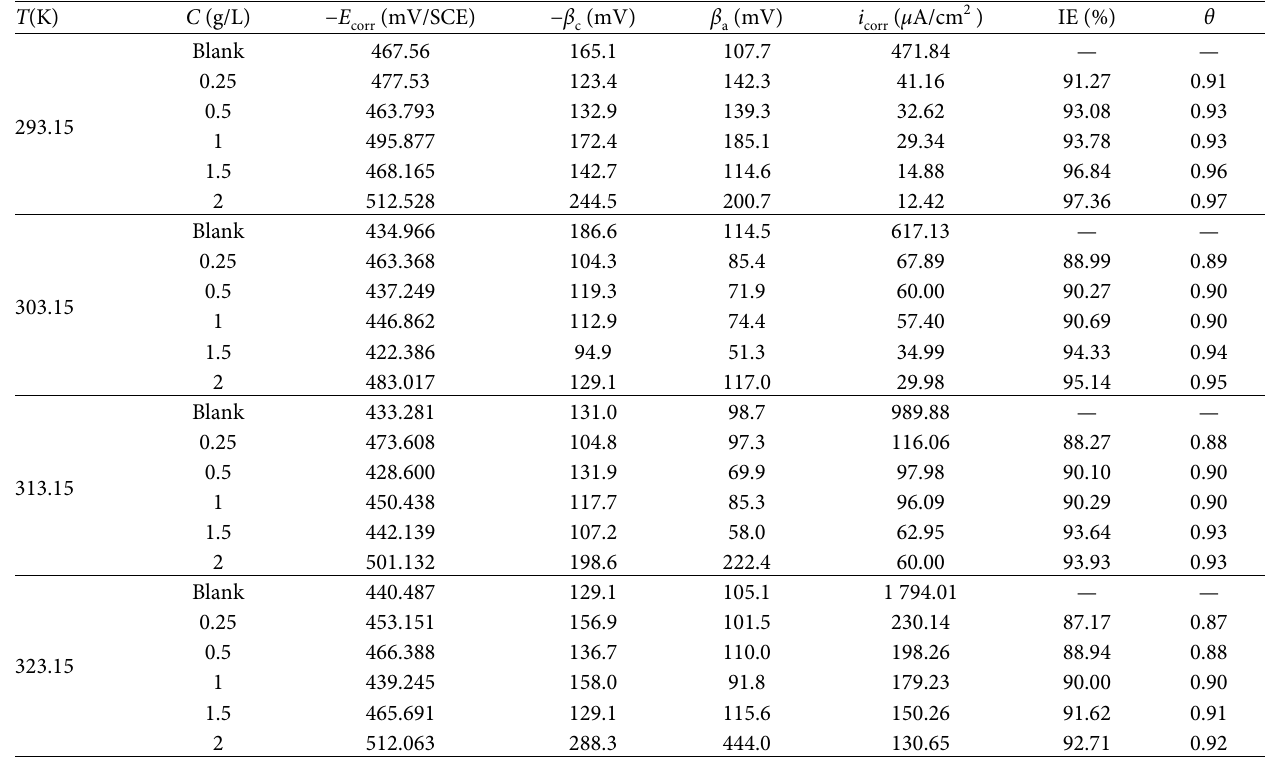
Table 2: Electrochemical parameters of C38 steel in 1 M HCl at different temperature and with different concentrations of HECG. T (K) C (g/L) − E corr